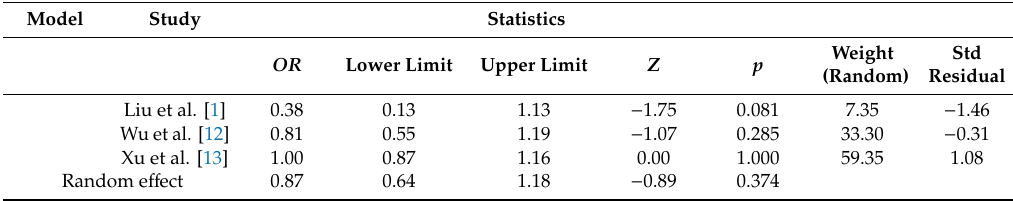
Table 3. Summary e ff ect sizes for high-density lipid cholesterol (HDL-C) serum levels and